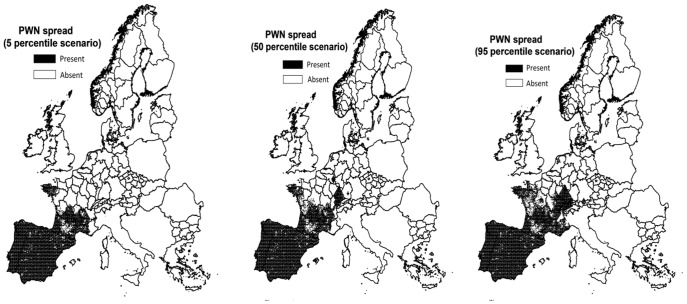
Simulated spread of PWN among Europe.Presented spread is based on the results of the 5th, 50th, and 95th percentile replication of total extent of spread according to the spread model of Robinet et al. [25].